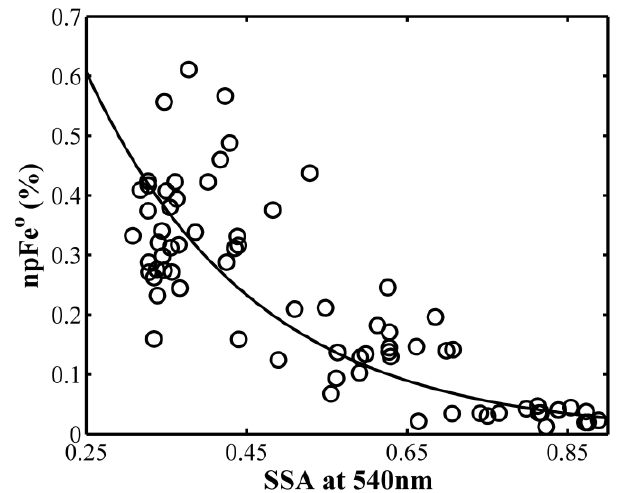
Figure 2. Correlation of SSA at 540 nm with npFe 0 for all size groups of LSCC soils.